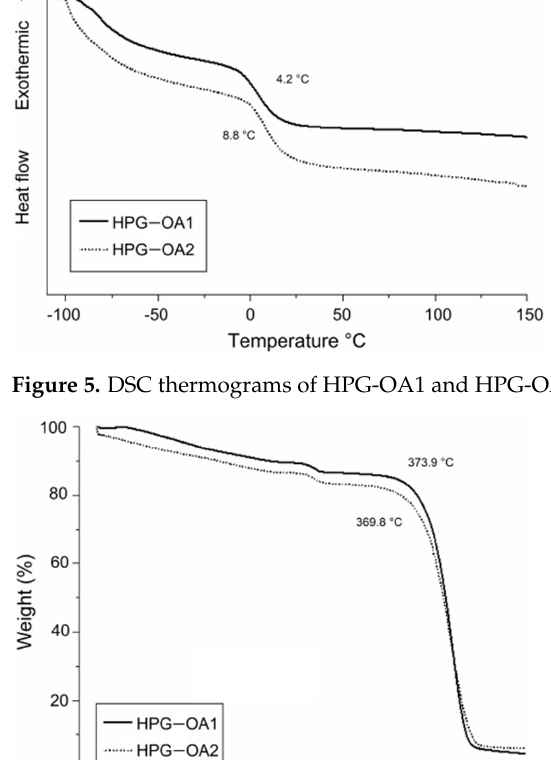
Figure 7. Optical microscopy images in transmission mode of HPG-OA1 hydrogels impregnated in ibuprofen (IBU) solutions of ( a ) 0.05 g mL − 1 (200×), ( b ) 0.5 g mL − 1 (400×) and ( c ) 0.75 g mL − 1 (400×). Figure 8. Photographs of the impregnated HPG-OA1 samples after the drying step. Samples impregnated in IBU solutions of ( a ) 0.05, ( b ) 0.5 and ( c ) 0.75 g mL − 1 . The dispersion of the drug in the form of crystals is a result of the moderate interaction of the IBU with the structure of the hydrogel. IBU presents two main sites of interaction, the aromatic ring and the carboxylic group [61]. In a previous work, it was